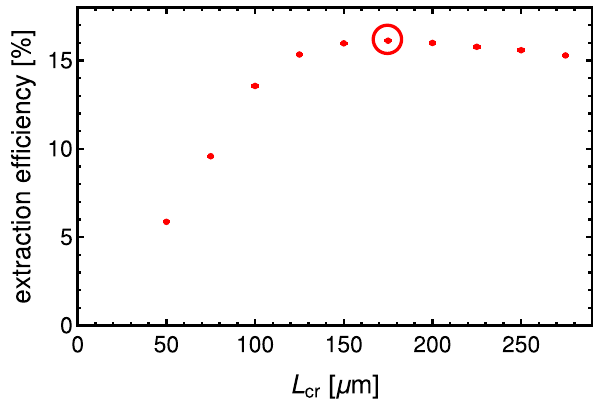
Fig. 16 Extraction efficiency as function of the crystal thickness for Si crystalsbentalongthe(111)planeswithadeflectionangleof1.75mrad. The red circle indicates the optimum case which is described in Table